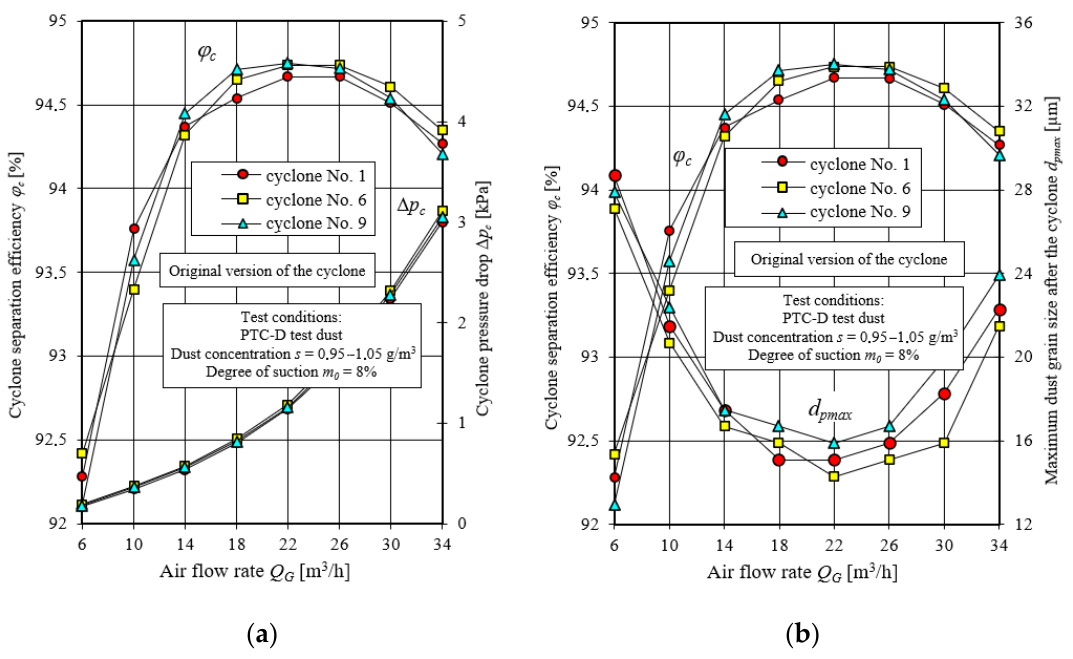
Figure 32. Characteristics of the original D- 40 cyclones: ( a ) separation efficiency φ c = f ( Q G ) and pressure drop Δ p c = f ( Q G ); ( b ) separation efficiency and accuracies φ c = f ( Q G ), d pmax = f ( Q G ).